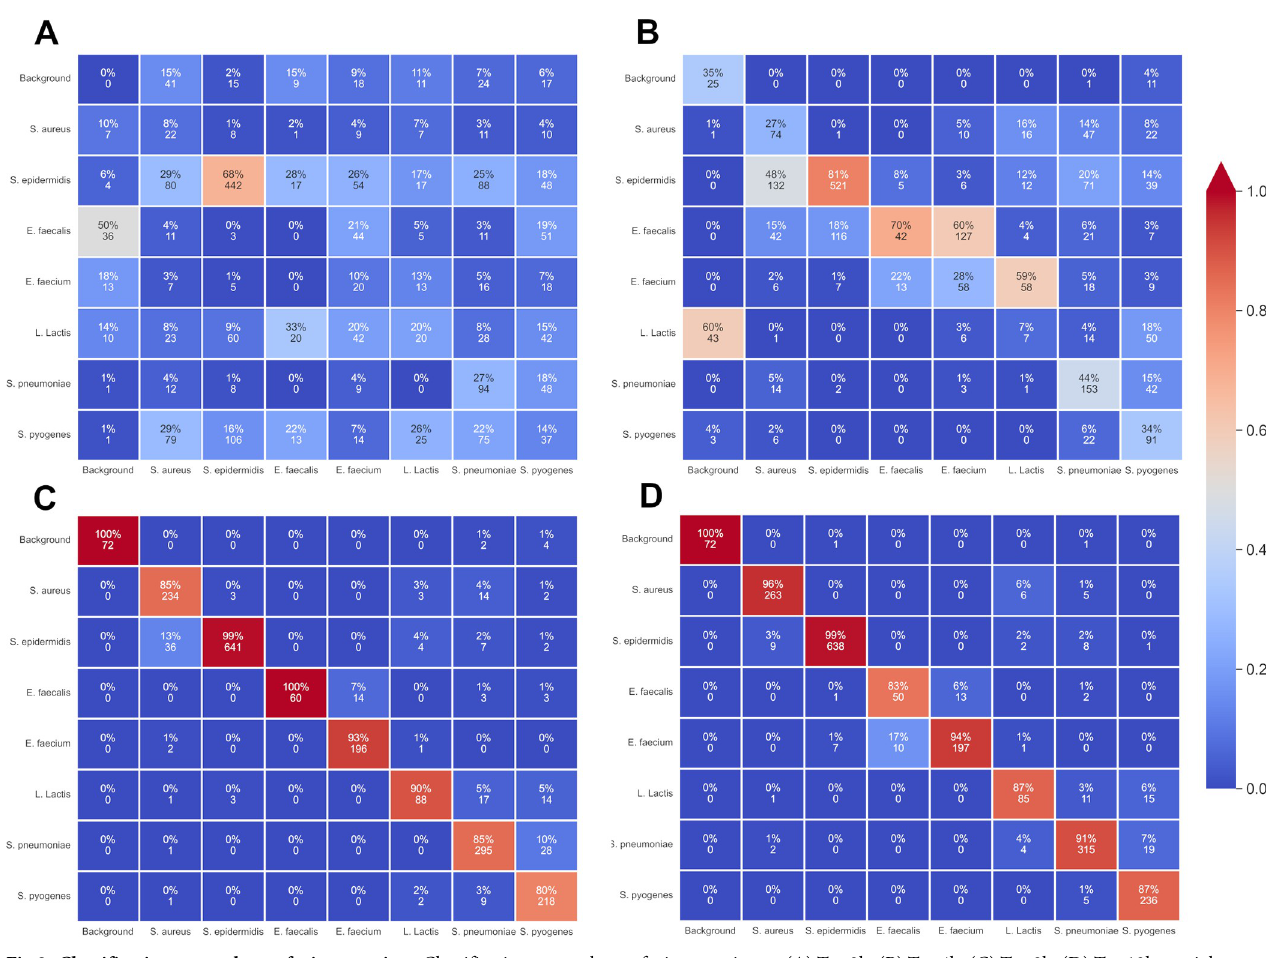
Fig 8. Classification networks confusion matrices. Classification networks confusion matrices at (A) T = 2h, (B) T = 4h, (C) T = 8h, (D) T = 12h on eight classes, which are Background, S . aureus , S . epidermidis , E . faecium , E . faecalis L . lactis , S . pneumoniae and S . pyogenes . Each matrix contains the predicted label of 275 S. aureus , 647 S. epidermidis, 60 E . faecalis and 210 E . faecium , 98 L . lactis , 347 S . pneumoniae and 271 S . pyogenes